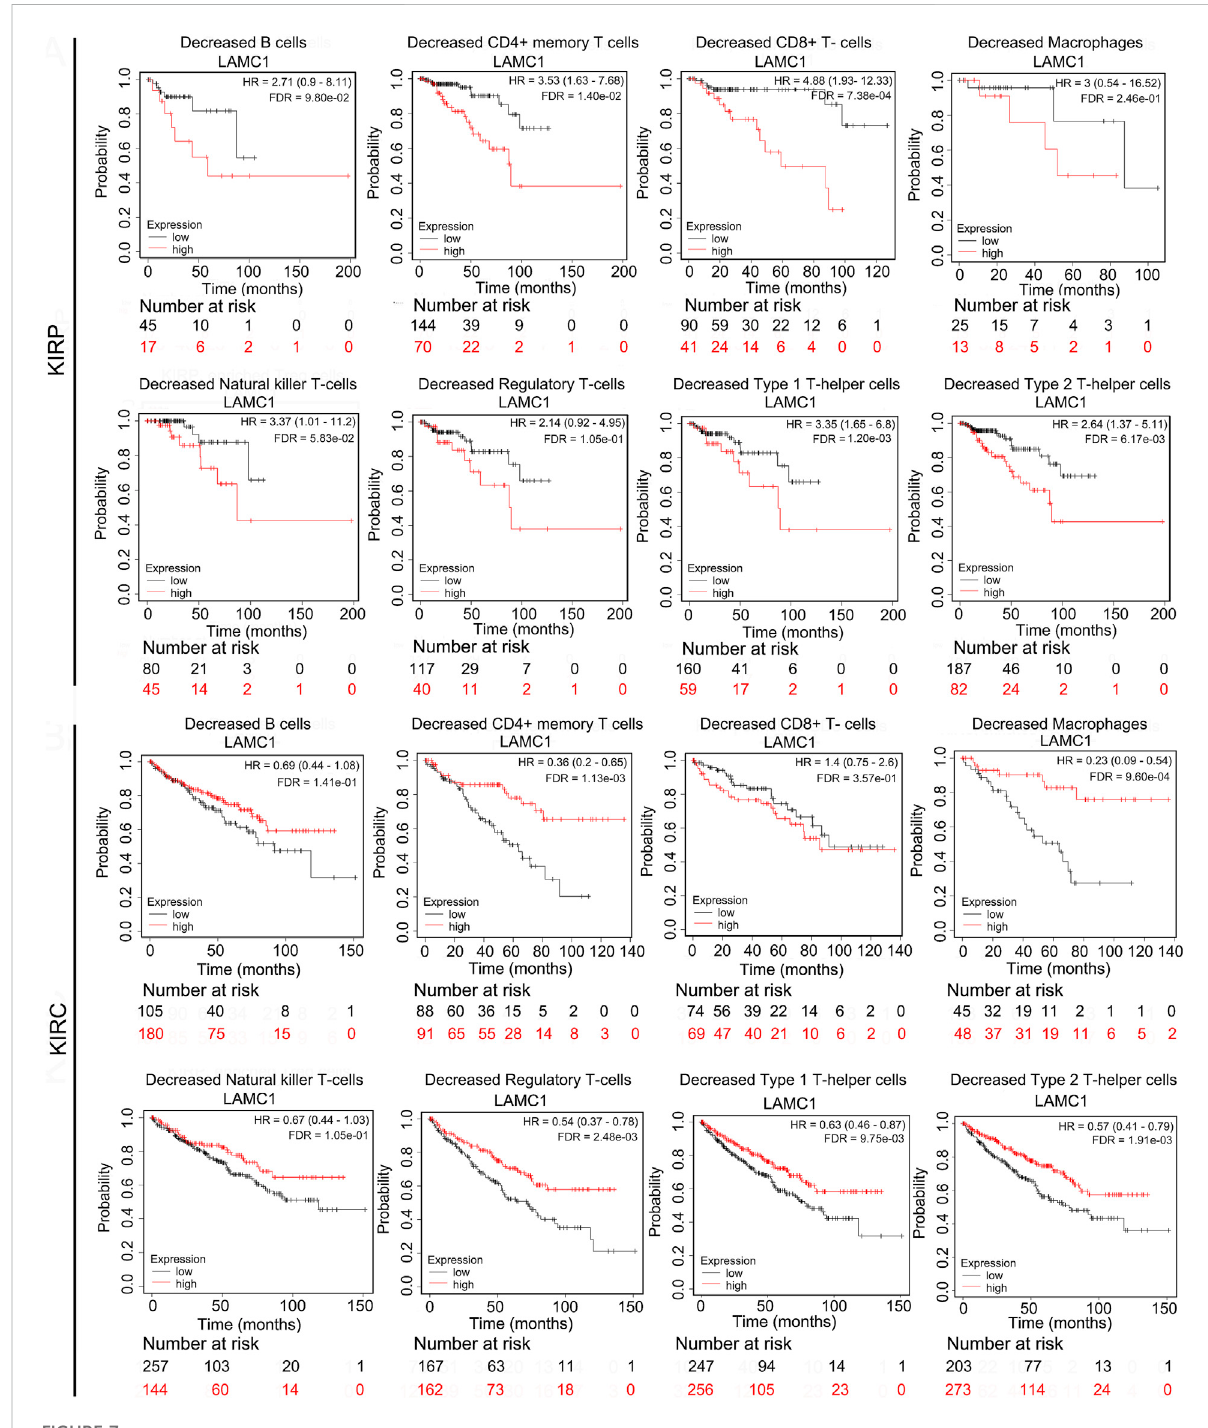
FIGURE 7 Kaplan – Meier survival curves for RCC patients with differential LAMC1 expression were constructed based on immune cells depletion in RCC